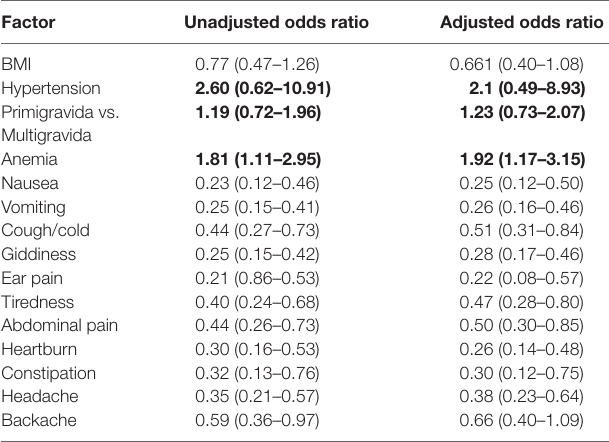
TaBle 4 | Multivariate analysis of medical and obstetric risk factors and mental distress in